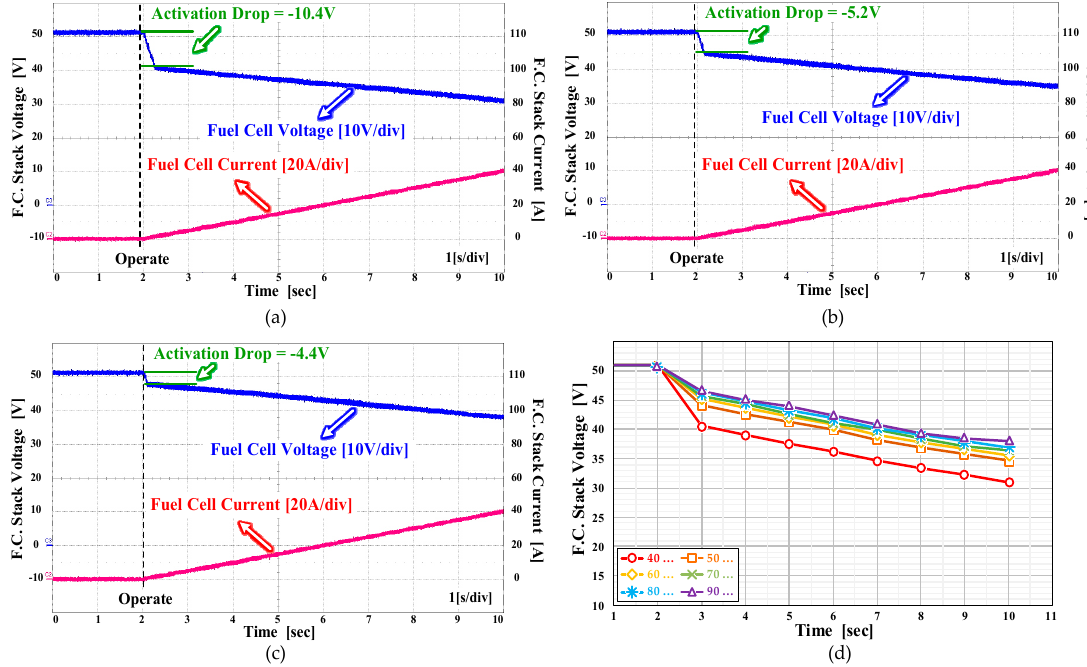
Figure 12. Fuel cell waveforms for stack temperature of the ( a ) 40 °C, ( b ) 70 °C, ( c ) 90 °C, and ( d ) voltage drop curve depending on the temperature of fuel cell stack.